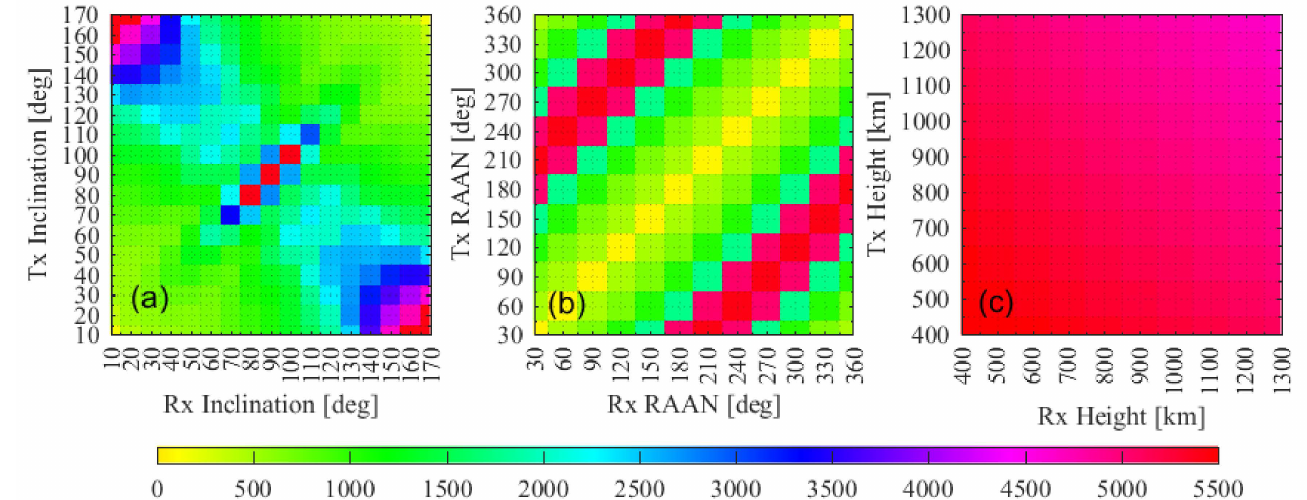
Figure 2. The variation in the 3-month accumulated LEO-LEO occultation event number (color scale) with the Rx and Tx orbital elements of inclination ( a ), RAAN ( b ), and height ( c